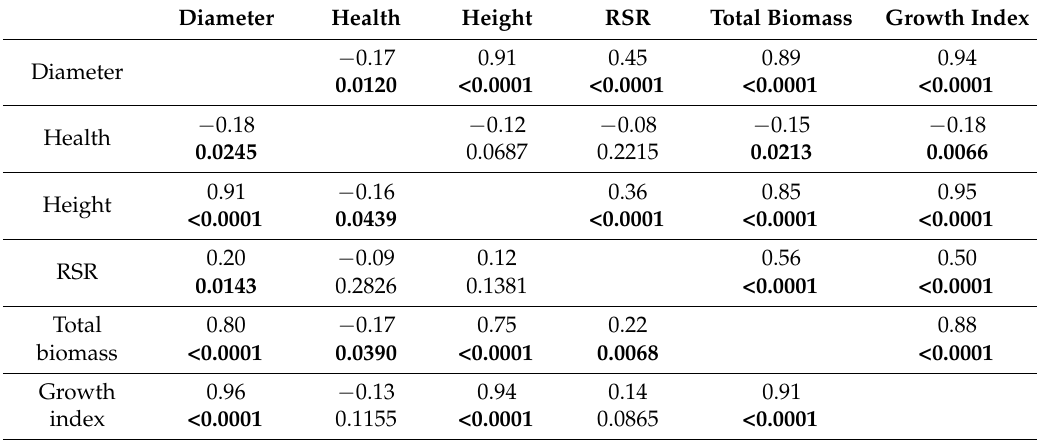
Table 5. Phenotypic correlations among six traits in a study assessing the relationships among root–shoot ratio (RSR), early growth, and health of hybrid poplar (above diagonal) and willow (below diagonal) clones when grown for 65 days in soils from five landfills in eastern Wisconsin, USA. Diameter Health Height RSR Total